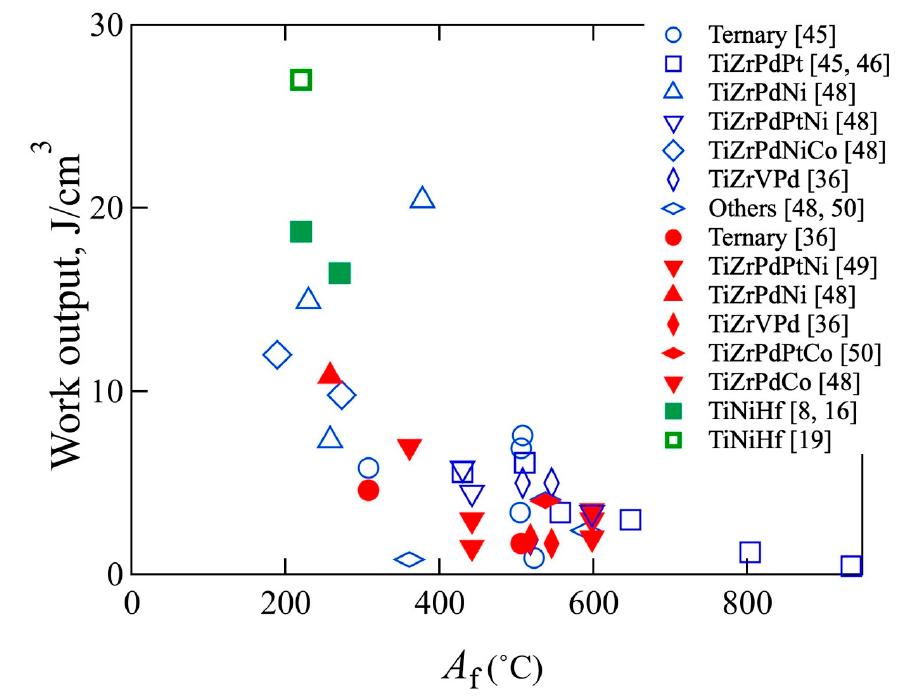
Figure 8. Work output vs. A f . The open and solid symbols represent the work output of the alloys with imperfect recovery and the work output of the alloys with perfect